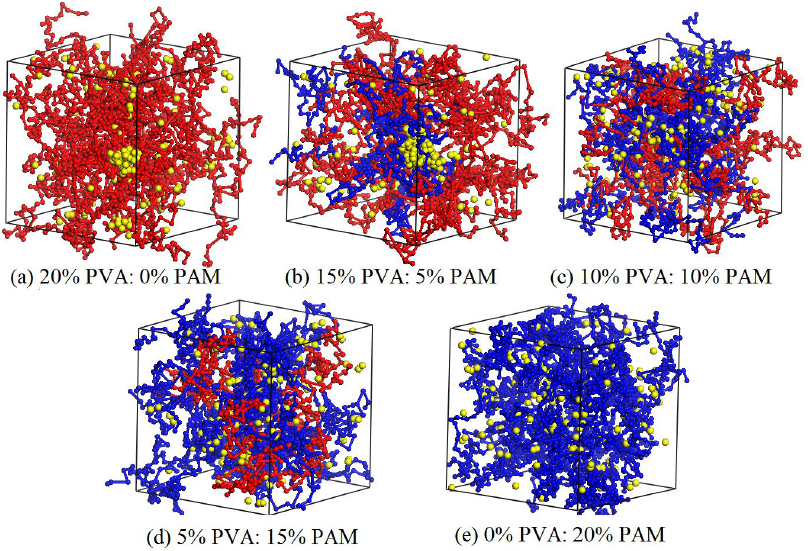
Figure 9. Equilibrated morphologies of PVA/PAM/1.5% nano-silica blended hydrogels with different